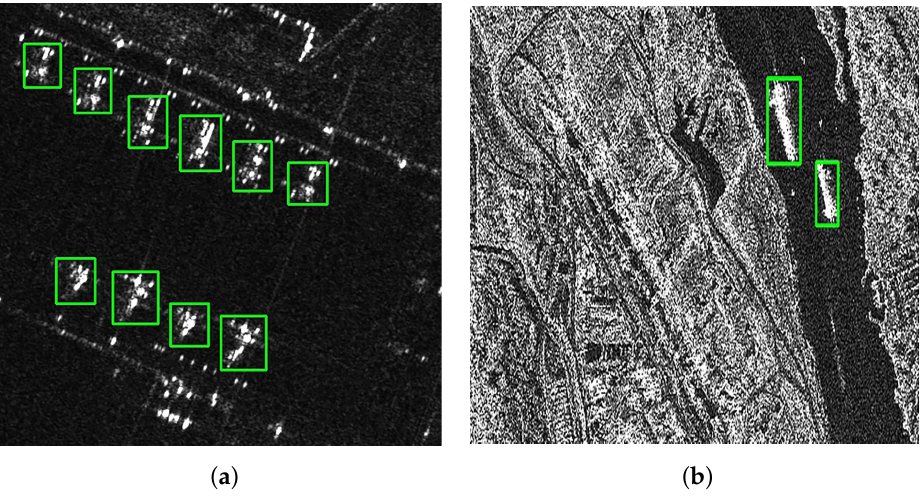
Figure 9. Dataset example. The green boxes represent the ground truth. ( a ) SAR-ADD. ( b )